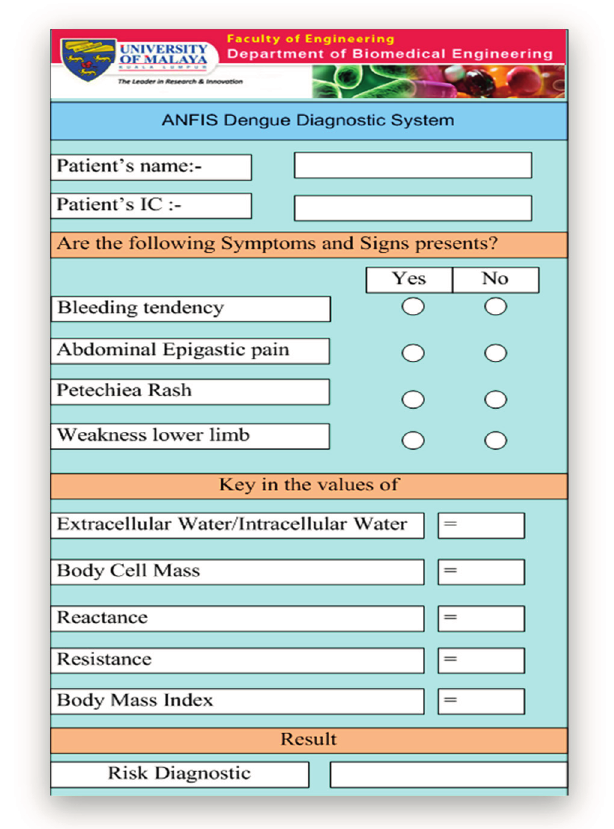
Figure 5. Dengue patient diagnostic system based on Adaptive Neuro-Fuzzy Inference